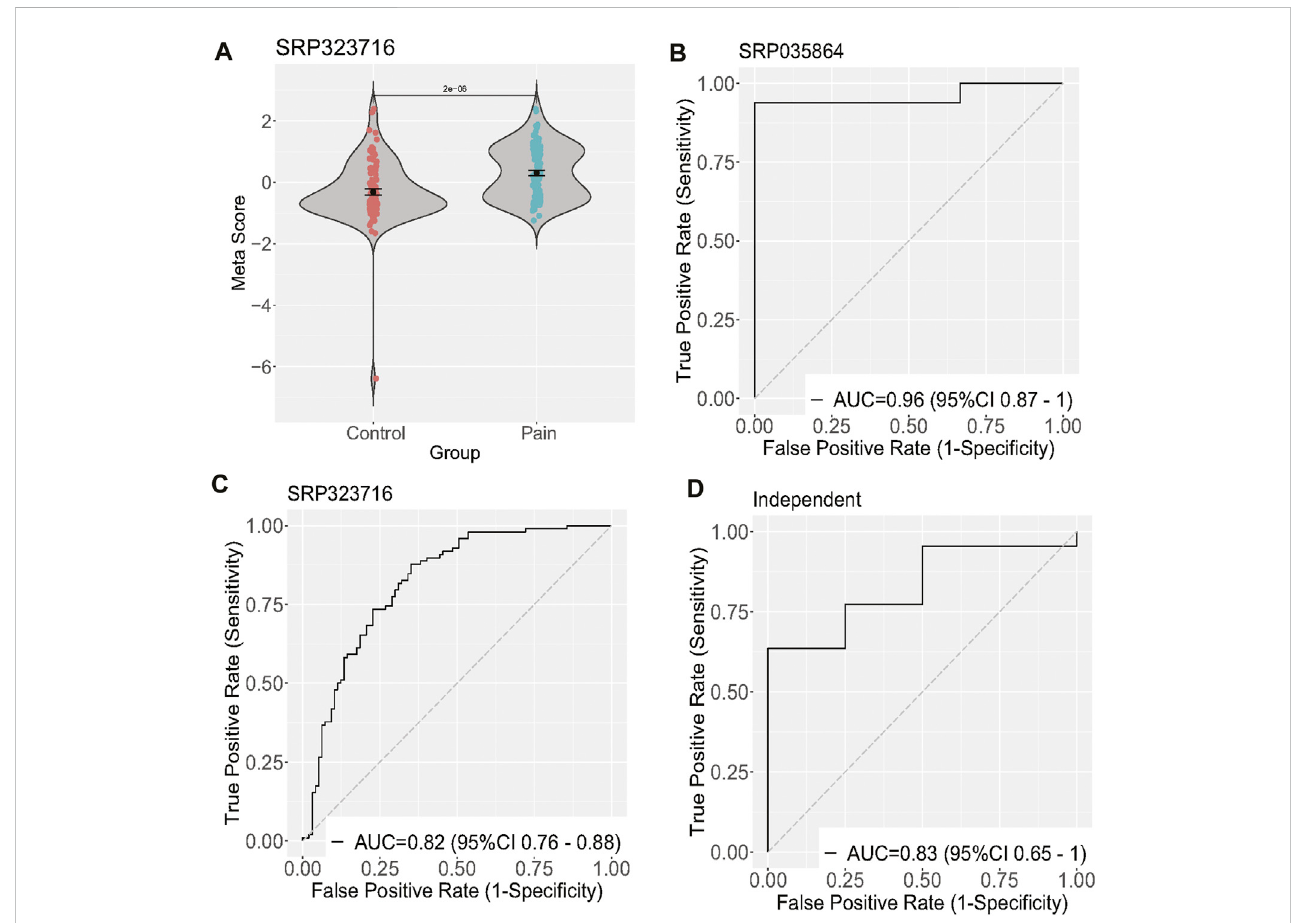
FIGURE 2 Validationof fi vedifferentiallyexpressedgenesofneuropathicpain. (A) Diagramillustratingthemeta-scoreofonetraining dataset; (B – D) ROCcurvesof patients with neuropathic pain versus controls in two training and one validation